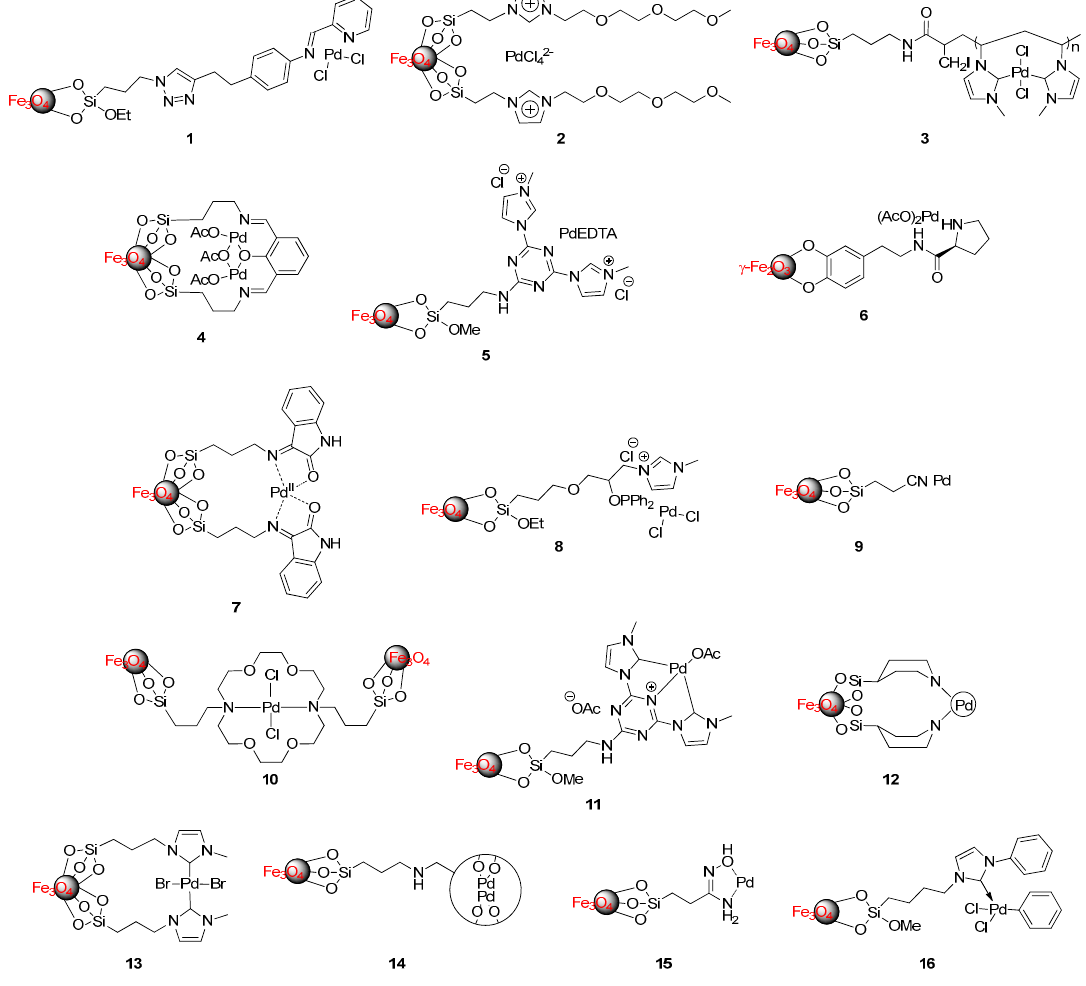
Figure 3. The structure of magnetically ‐ supported palladium catalysts used in Suzuki–Miyaura cross ‐ coupling reactions.